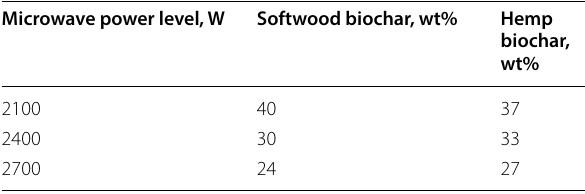
Table 4 Biochar yield per microwave power level Microwave power level, W